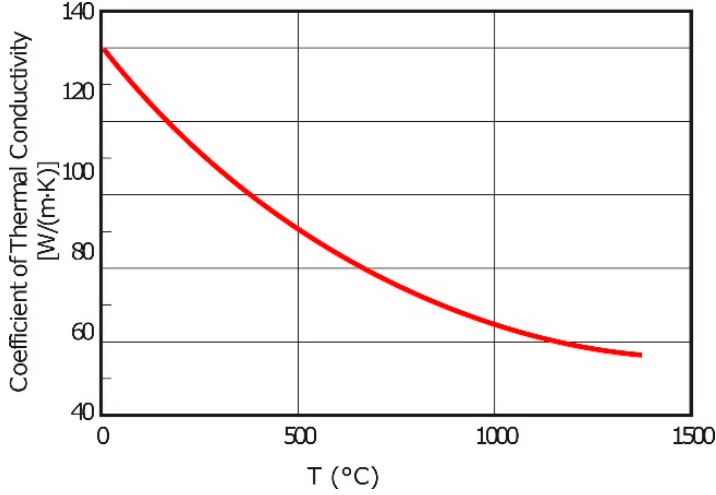
Figure 4. Thermal conductivity coefficient of the used graphite crucible vs. temperature.